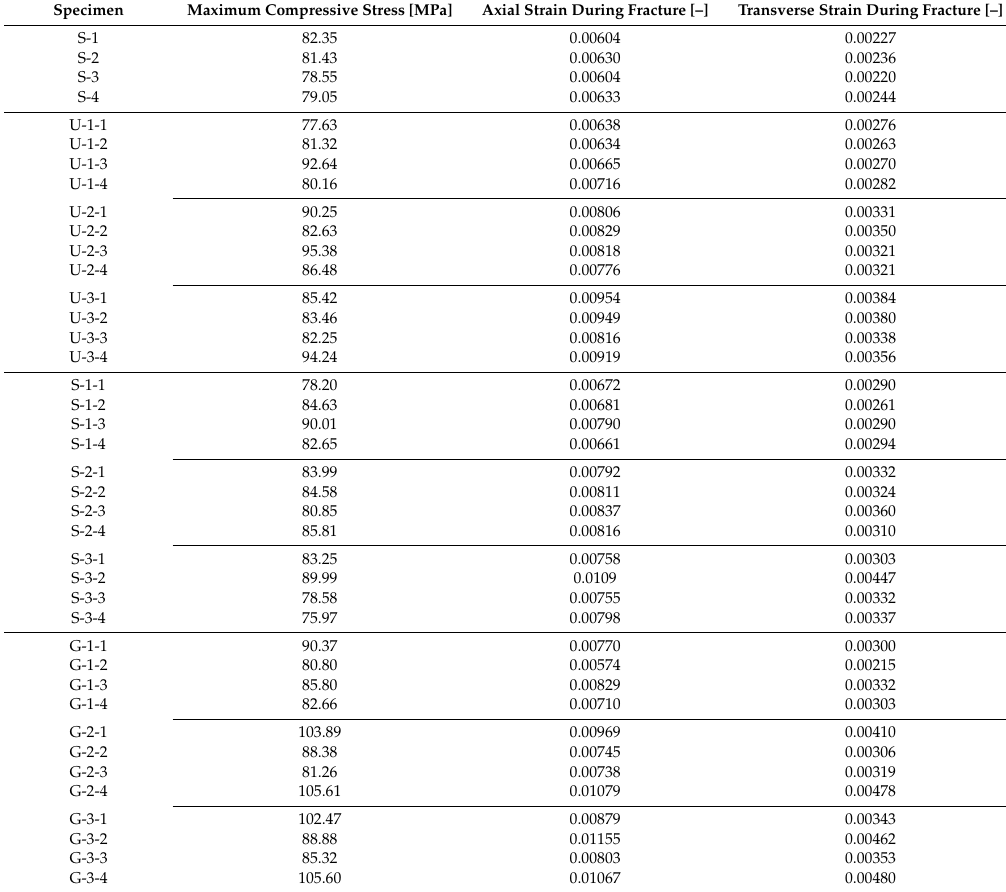
Table 2. Detailed results for the samples reinforced with cement matrix.